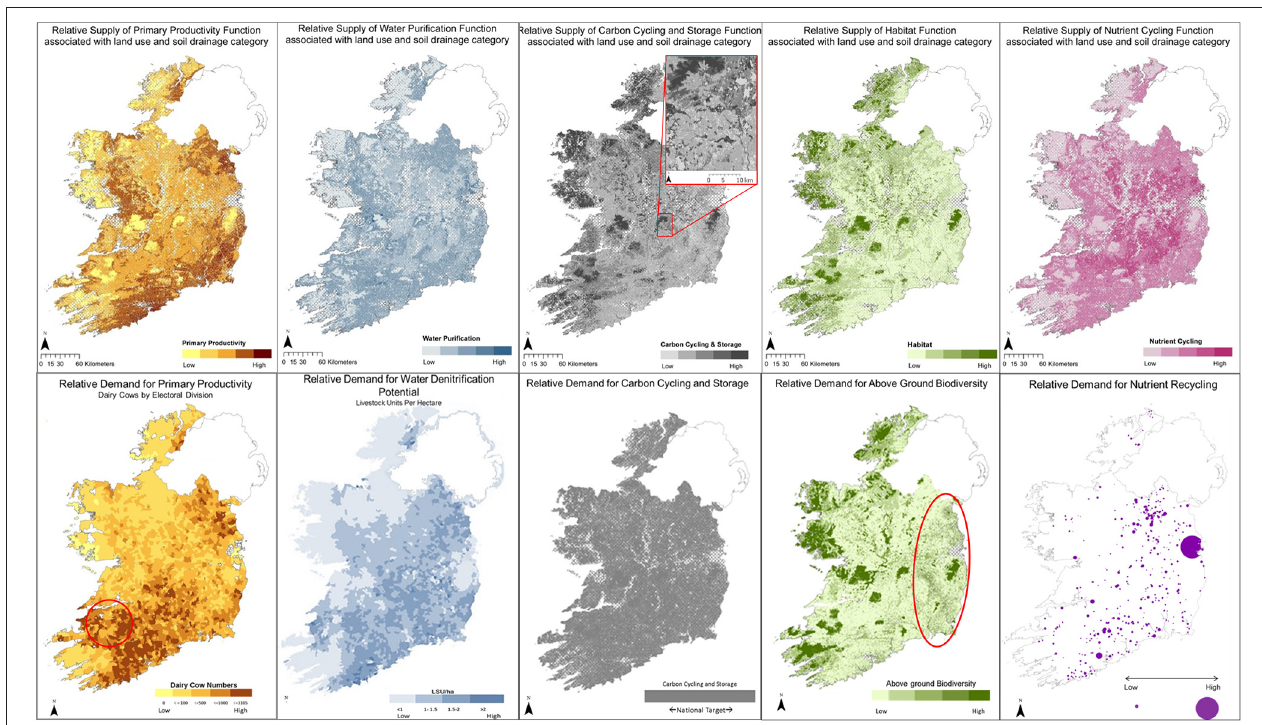
FIGURE 5 | Indicative maps of the normalized supply (top row) and demand (bottom row) for the five soil functions, from left to right: primary productivity, water purification, carbon sequestration, biodiversity, nutrient cycling. The red circle and oval indicate areas, discussed in the text, where the demand for primary productivity and biodiversity, respectively, may exceed the current supply of these two functions.